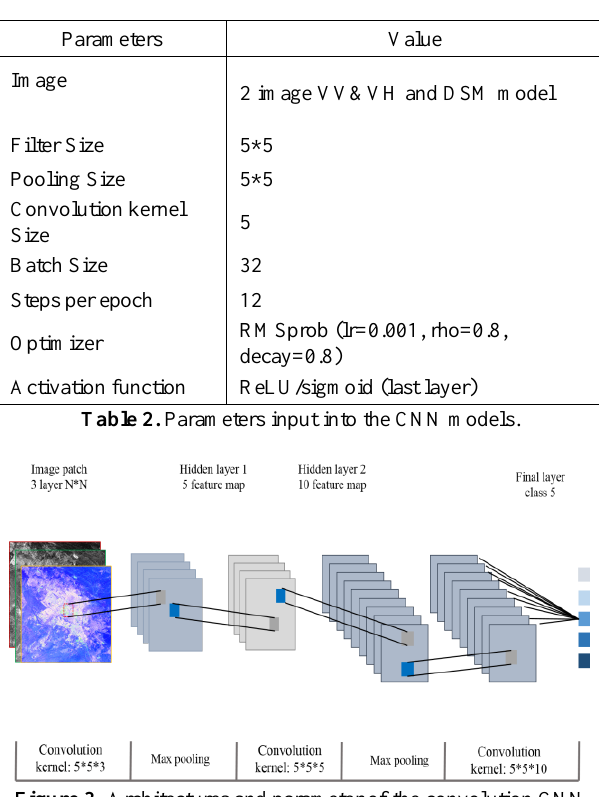
Figure 3. Architectures and parameter of the convolution CNN model in this